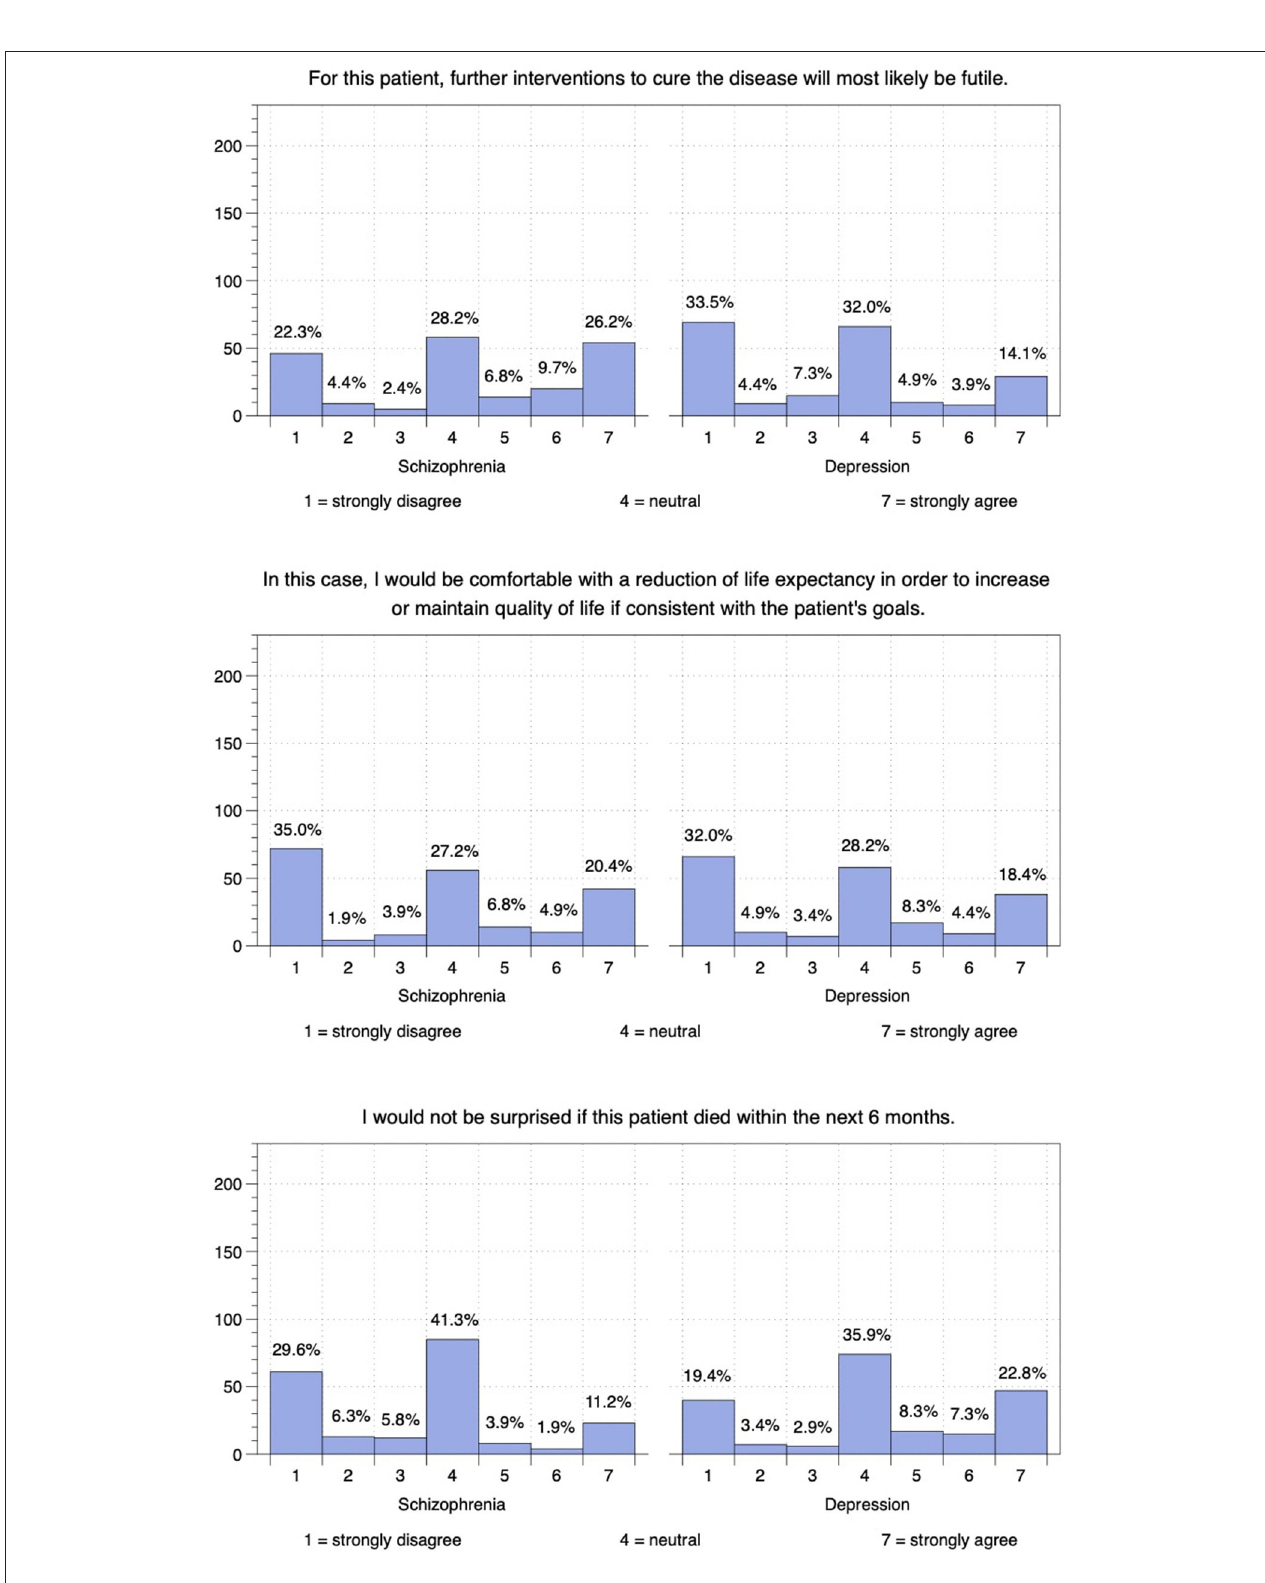
FIGURE 3 | Indian psychiatrists’ attitudes on the case vignettes.